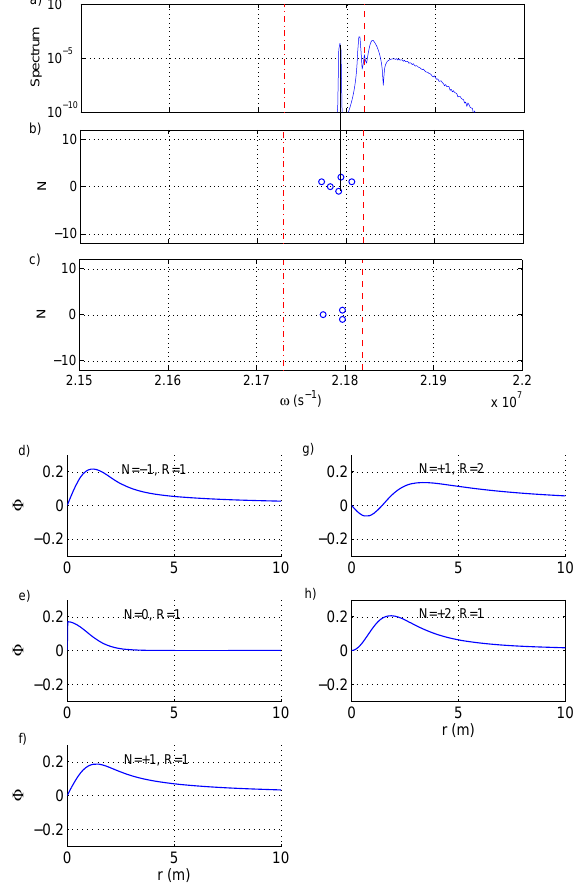
Figure 2. (a) The frequency spectrum (arbitrary units) of UH os- cillations at the center of a shallow striation ( α = 0 . 01). (b–c) : res- onances indicated by circles, showing the eigenfrequencies ω and azimuthal-mode numbers N for (b) the coupled Eqs. (9)–(10) and (c) the Schrödinger equation (13). The vertical dash-dotted and dashed lines indicate the local UH frequency at the center of and outside the striation, respectively, and a vertical solid line connects a spectral peak in (a) with the resonance for N = − 1 in (b) . (d– h) Spatial profiles (arbitrary units) of the radial eigenmodes corre- sponding to the resonances (see panel b ), for trapped UH waves.